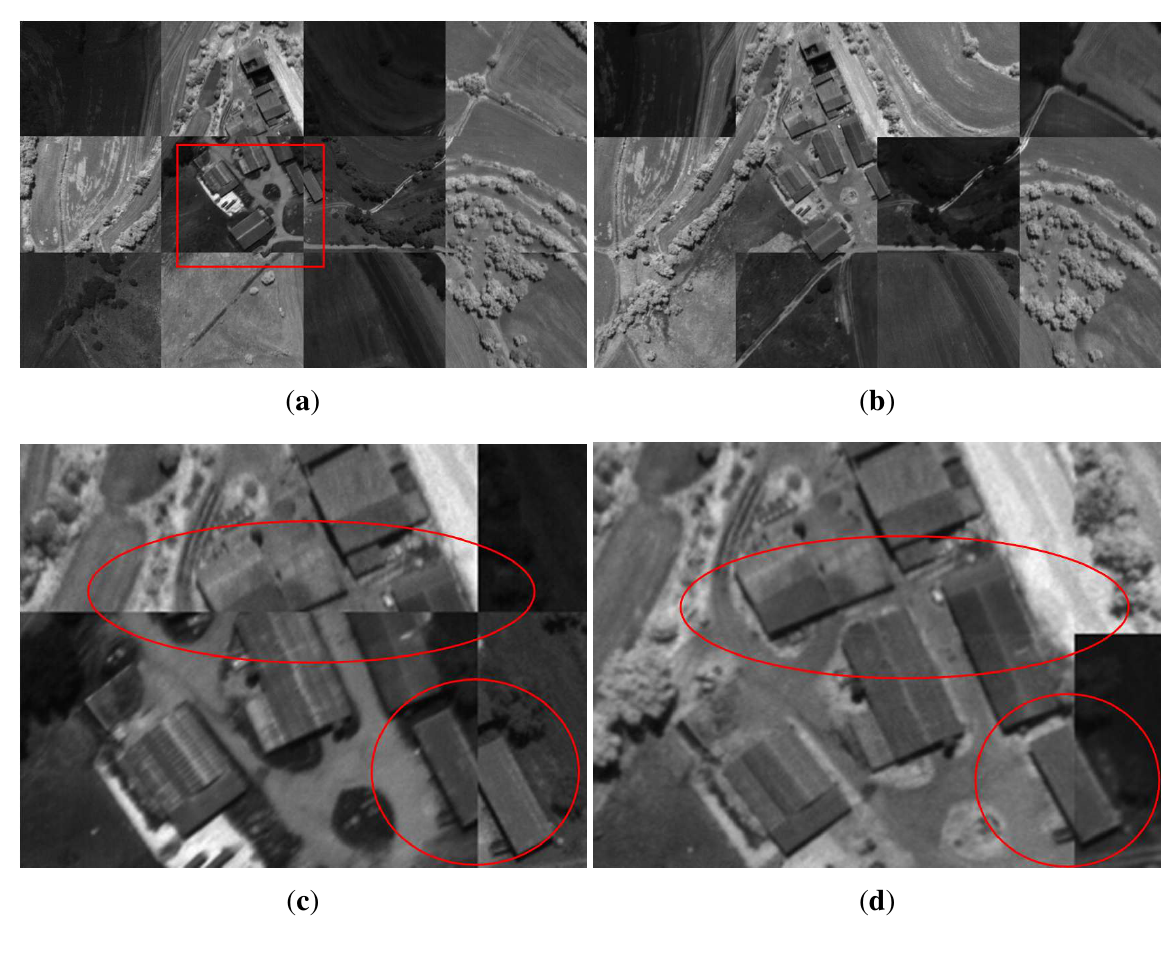
Figure 7. Registration results after the application of the developed methodology. The quantitative evaluation (Table 1) indicate an overall sub-pixel accuracy of approximately 0.66 pixels (dataset # 5) ( a ) Raw Unregistered Data]; ( b ) Registered Data; ( c ) Zoom at Raw Data; ( d ) Zoom at Registered